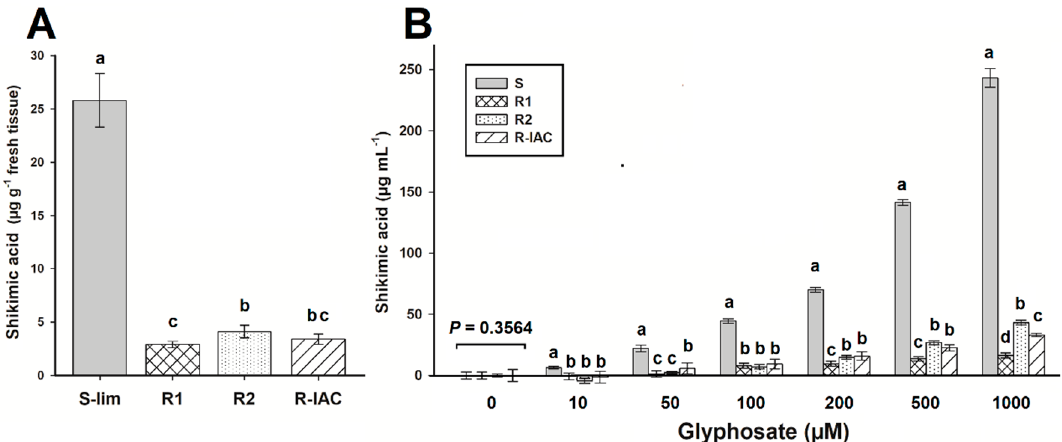
Figure 2. Shikimic acid accumulation in glyphosate-susceptible and -resistant slender amaranth ( Amaranthus viridis L.) populations collected in citrus orchards from São Paulo State, Brazil. ( A ) Shikimic acid accumulation in sprayed plants with 360 g ae ha − 1 at 96 h after treatment. ( B ) In vivo shikimic acid accumulation at different glyphosate concentrations. Groups of bars with the same letter above them are not di ff erent using the Tukey test at 95%. Vertical bars represent the standard error of the mean ( n = 9 technical replicates).